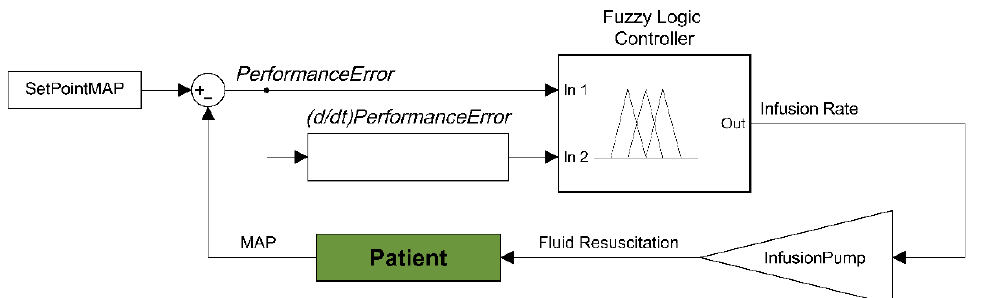
Figure 1. Diagram of the dual input fuzzy logic controller for hemorrhagic shock resuscitation. Two inputs to the fuzzy logic controller are derived from input pressure readings and the distance from set point mean arterial pressure − performance error and rate of performance error change. These two inputs are used to determine an infusion rate output for providing fluid to resuscitate and stabilize pressure. Each controller was set with the same types of membership functions, but with varying constants. DFL 1 − 4 classified PerformanceError into three fuzzy sets: VeryLow , Low , and Set . DFL 5 used these same three with an additional set called Over . All controllers used z-shaped membership functions for mapping PerformanceError into VeryLow and s-shaped membership functions for Set . DFL 1-3 used simple Gaussian curves while 4 and 5 used generalized bell-shaped membership functions for mapping PerformanceError into Low . DFL 5 also used an s-shaped membership